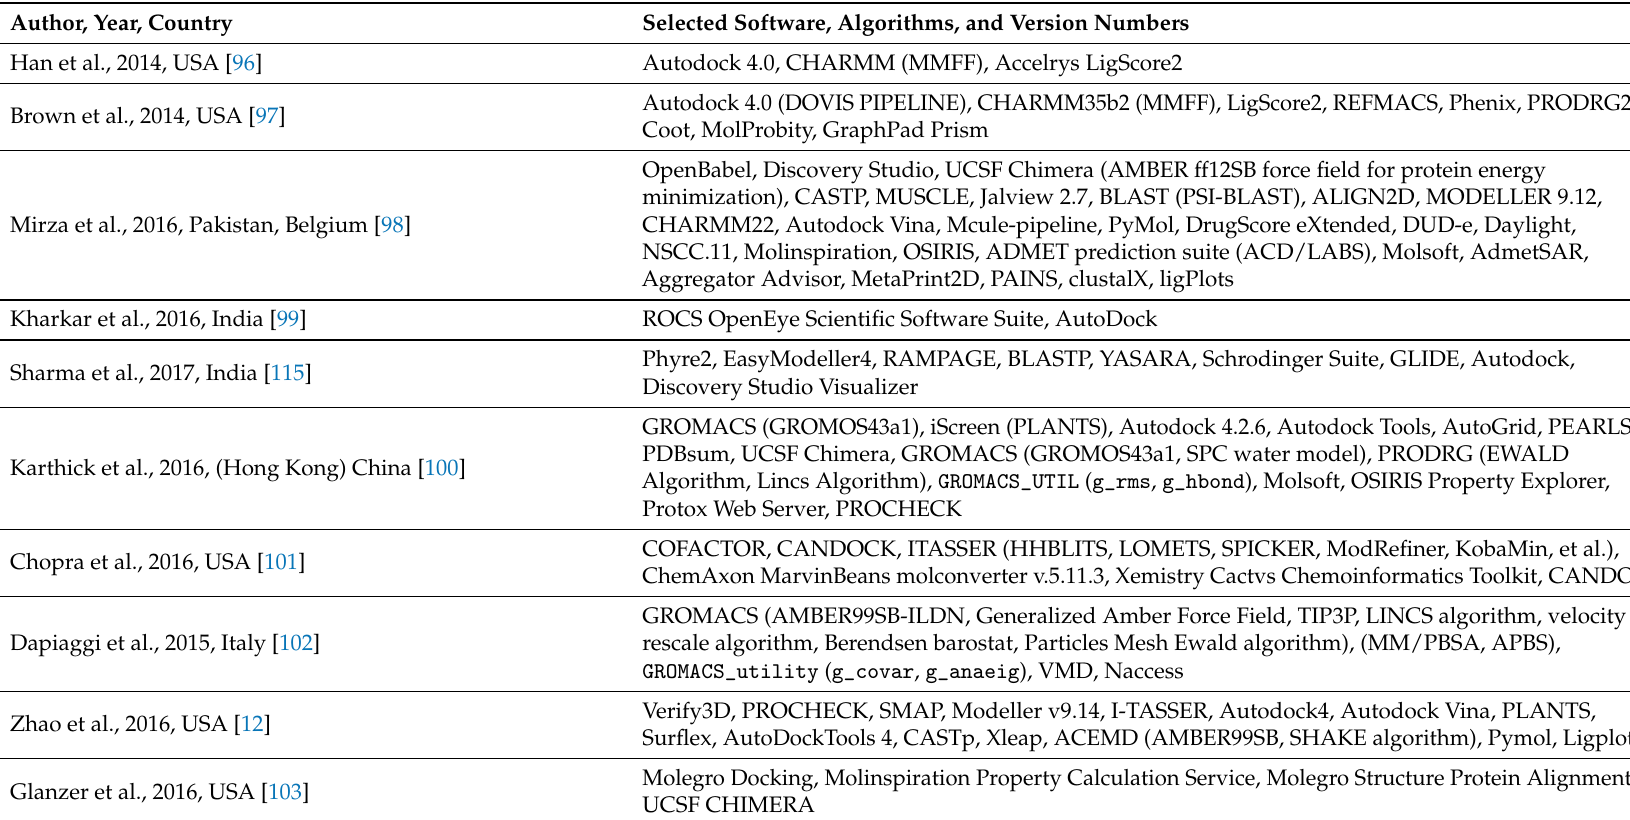
Table 4. A selection of software used in the studies reviewed. Generally, authors only reported primary scientific software used. Other software, automation scripts, operating systems, cluster management software, APIs, or other elements of the studies were usually not specifically reported. Some authors reported abstract or architectural descriptions of computational pipelines or platforms. Reproducibility of future work can be enhanced by reporting details on the entire software stack, software parameters, and hardware environment. A standard protocol for reporting the computational environment is needed in order to facilitate the comparison of